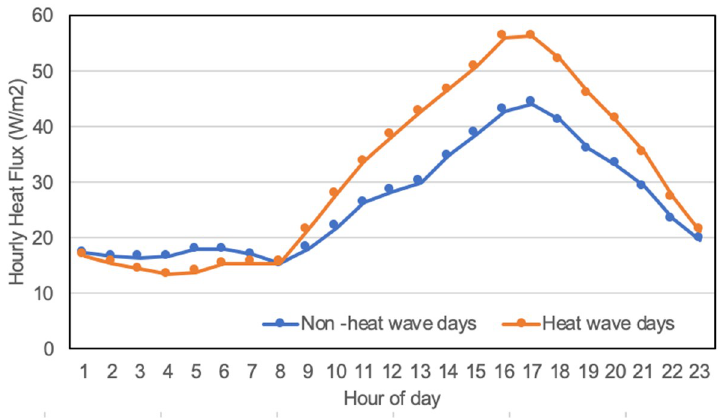
Figure 12. Diurnal profile of the hourly AH flux during non‐heatwave and heat wave days.